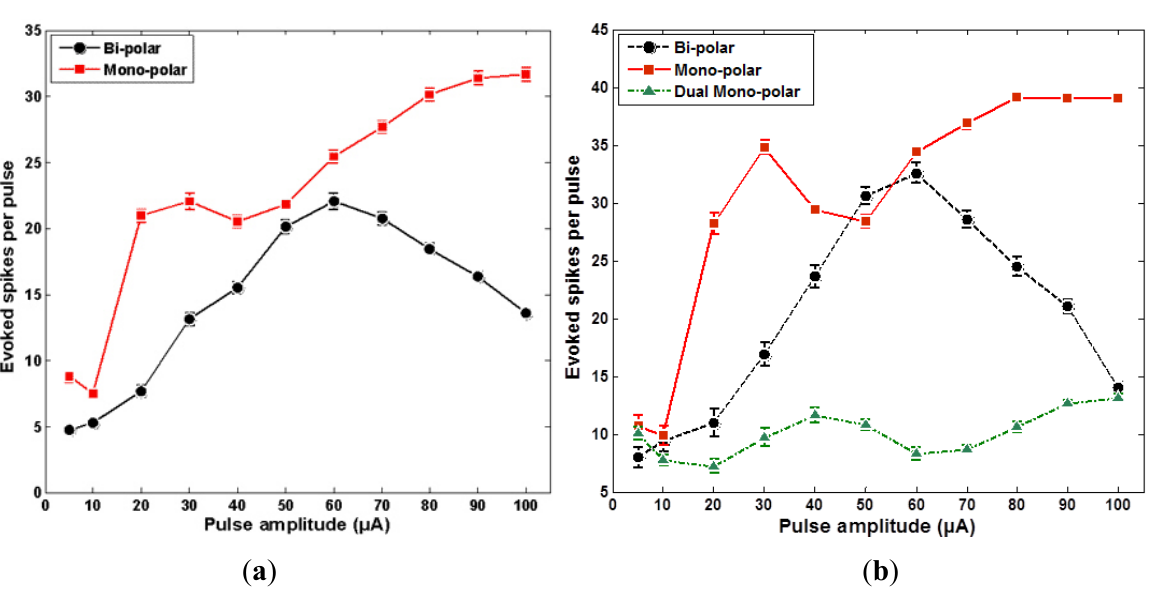
Figure 8. The graph of average number of the evoked RGC spikes. ( a ) Average number of the evoked RGC spikes of the 1–6, 4–3, 5–3, and 7–1 electrodes in both monopolar and bipolar stimulations. ( b ) Average number of the evoked RGC spikes of the 7–1 microelectrodes in all